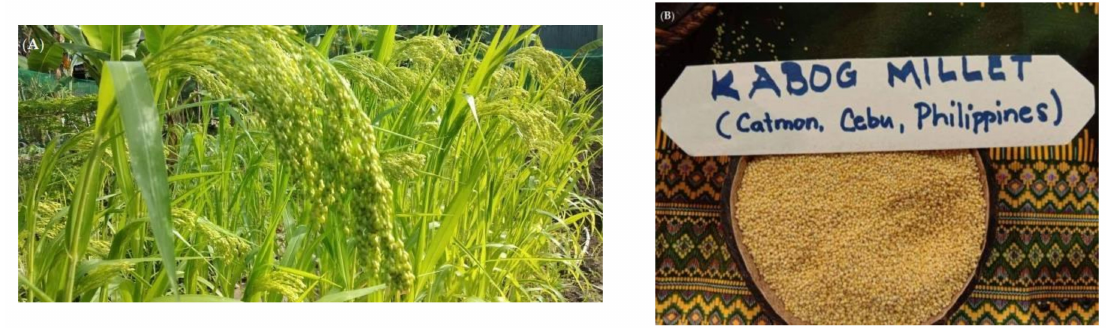
Figure 1. Kabog millet plants ( A ) and kabog millet grains ( B ). Photo credits: Mrs. Rosaflor